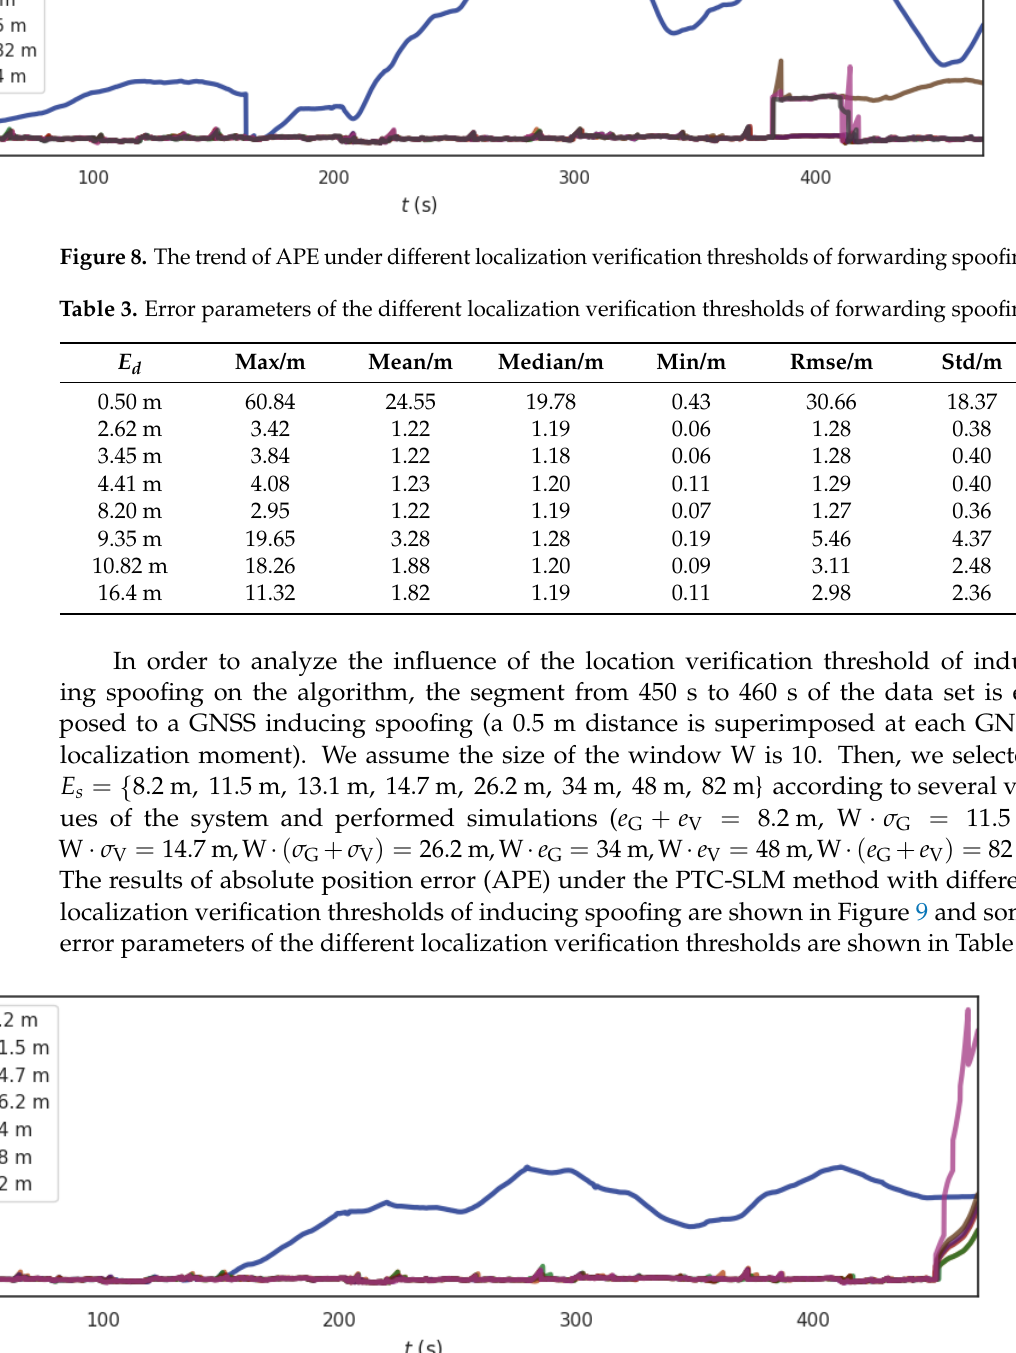
17 of 26 Figure 7. The joint probability density distribution of the GNSS/visual SLAM system. ( a ) Total joint probability, ( b ) Joint probability greater than 99.37%. From the simulation results of the joint probability density distribution, it is known that the confidence interval for the joint probability density of the GNSS/visual SLAM system to be greater than 99.37% is